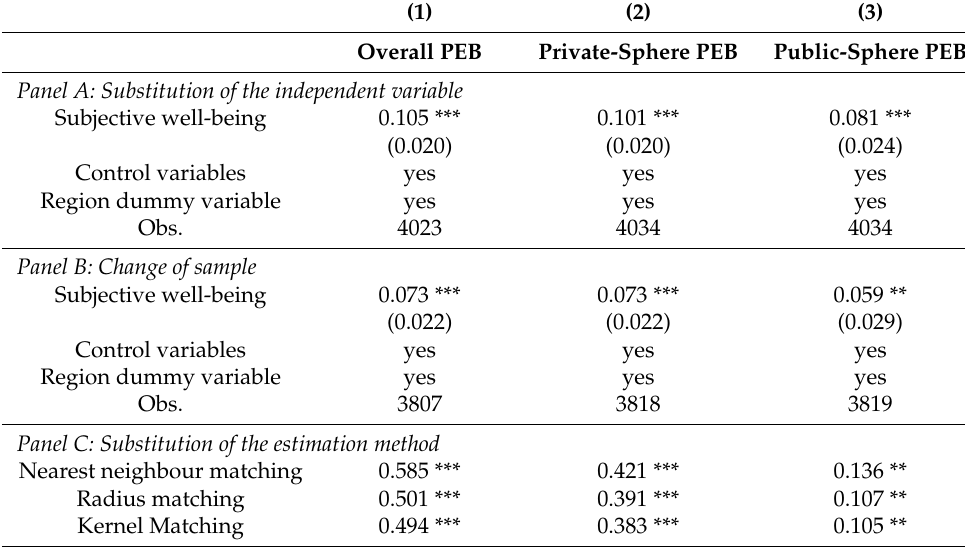
Table 4. Robustness